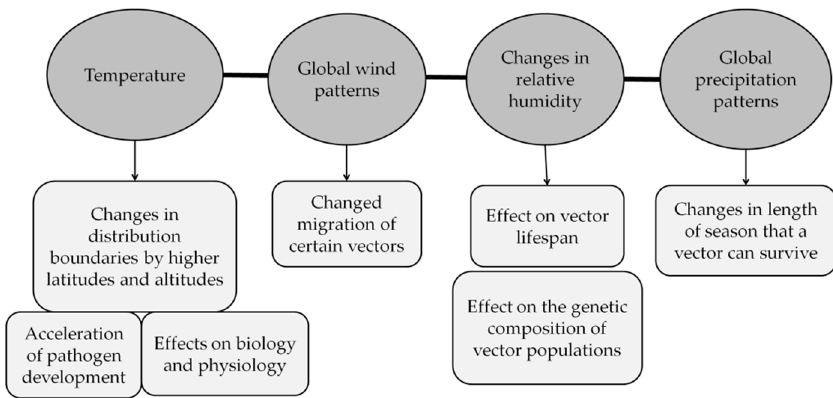
Figure 5. Direct effects of climate change on disease vectors adapted from Reference [54] Columbia Earth Institute Climate Nexus.